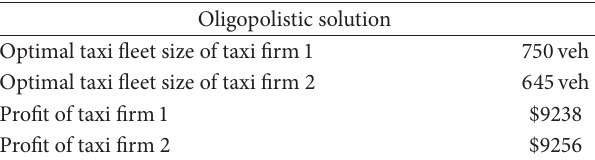
Table 4: The oligopolistic solution when vacant taxis are exempted from